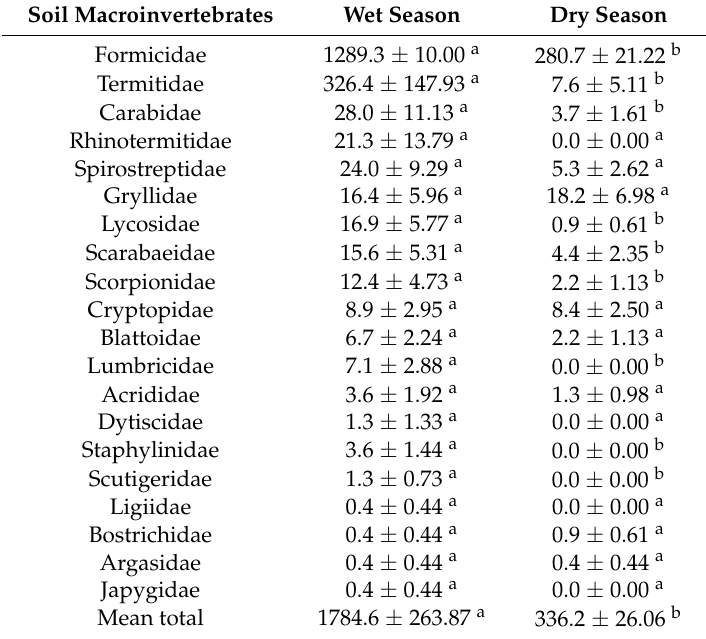
Table 6. Effect of season on abundance of SMI (individuals m − 2 ) (Mean ± SEM).